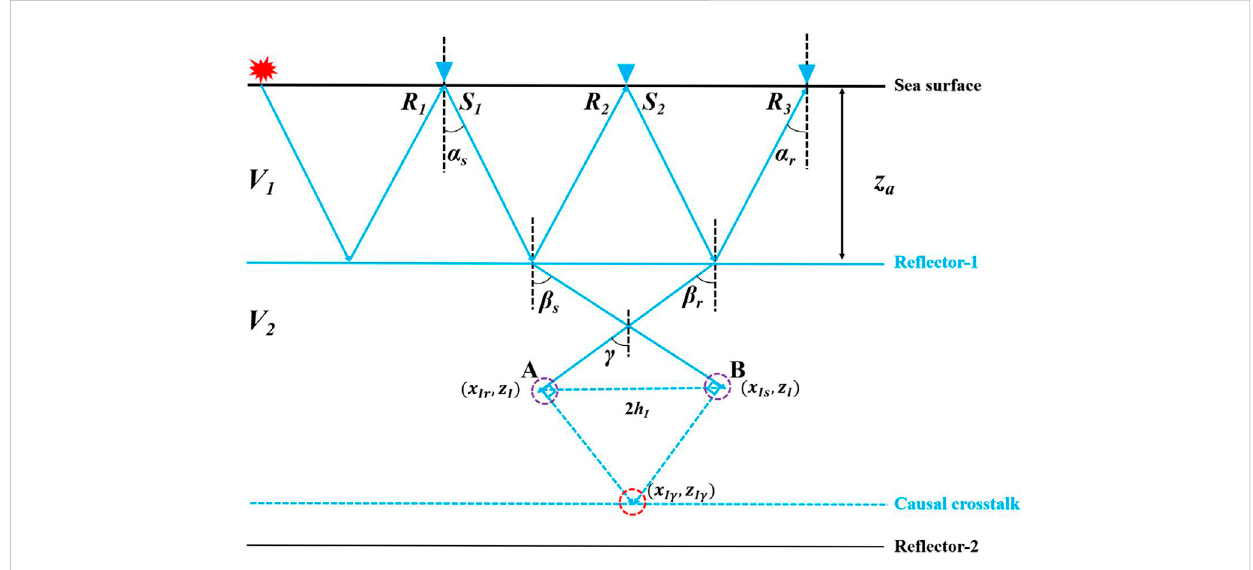
FIGURE 3 Raypathsforgeneratingcausalcrosstalk. V 1 and V 2 arethevelocityofthe fi rstandsecondlayers,respectively. z a isthedepthofthere fl ector-1. α s and